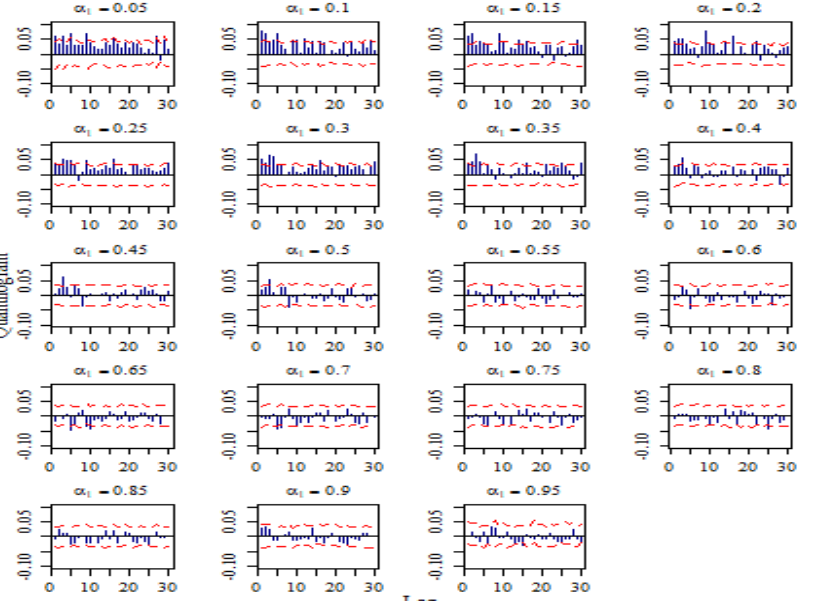
Figure 3. Sample cross-quantilograms, to capture directional predictability from WTI to OVX, when both return series are in the same quantiles. Results with lag k = 1, 2, …, 30. The dashed lines denote the 95% bootstrapped confidence intervals.